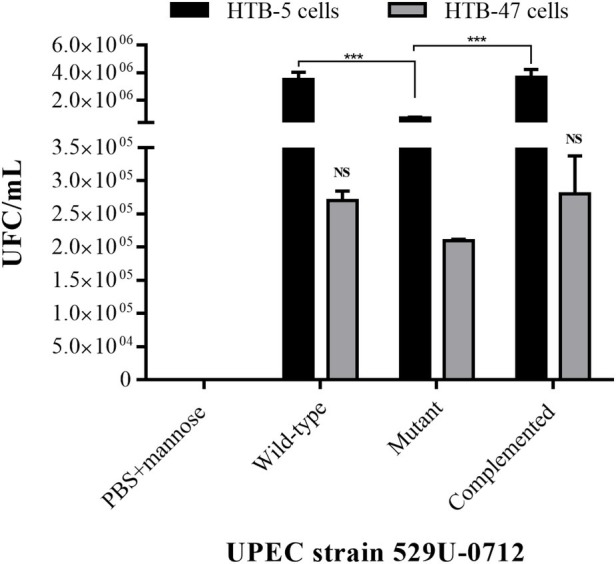
Assays of adherence to bladder HTB-5 cells and renal HTB-47 cells. The wild-type and complemented strains showed similar adhesion profiles, and a significant reduction (p < 0.001) in the mutant strain was observed in bladder cells. In renal cells, no significant differences were identified among all UPEC strains. Quantification of CFU/ml was performed by a plaque microdilution method. The bars represent the mean ± S. E. of three independent experiments. Uninfected cells were used as a control in this experiment. NS = not significant (p > 0.5); *** < 0.001.